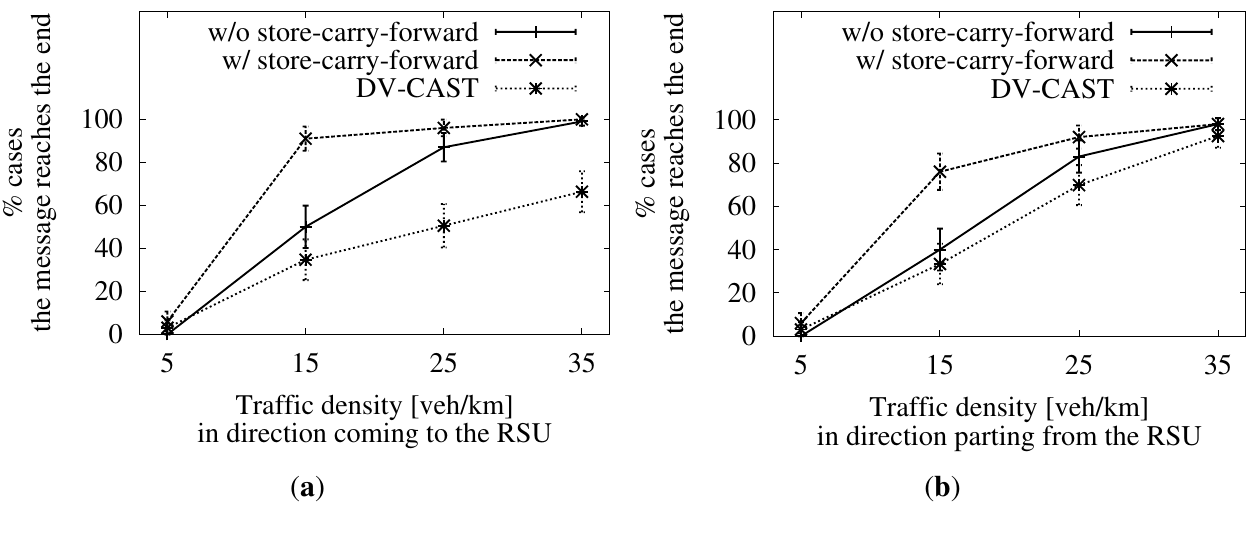
Figure 12. Success rate of our approach with and without store-carry-forward and of DV-CAST. Density variations in one direction influence the performance. The other direction has a fixed traffic density of five vehicles/km. Confidence interval of 95%. ( a ) Five vehicles/km in the direction parting from the roadside unit (RSU); ( b ) five vehicles/km in the direction coming to the